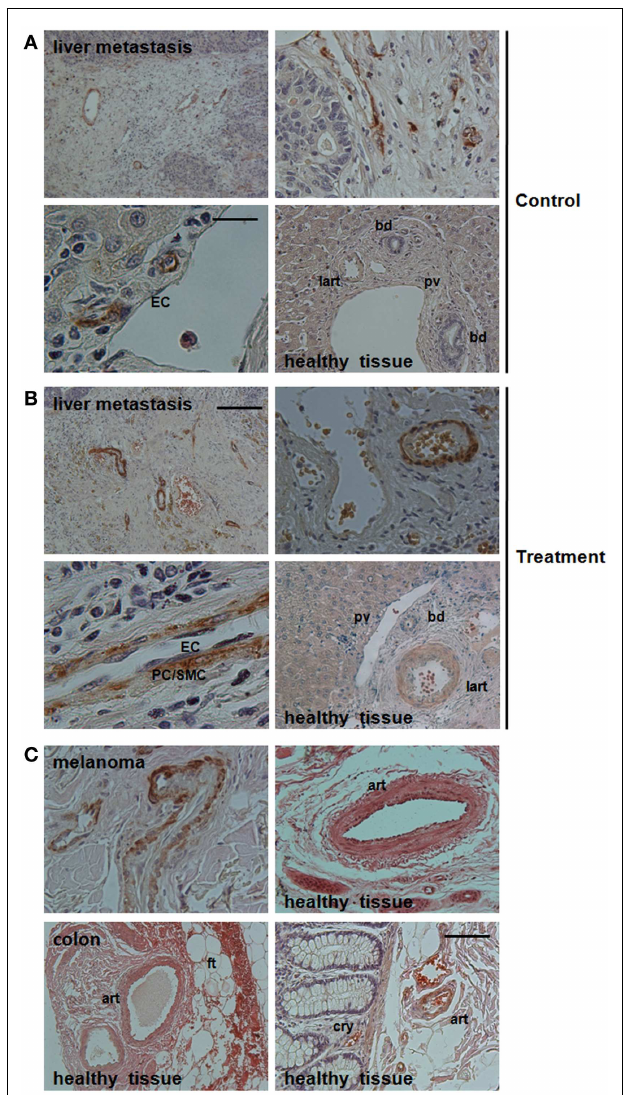
FIGURE 1 | Immunohistological analysis of Nestin-expression in vessel structures in bevacizumab-treated human tumor tissues . (A) Paraffin-sections of liver metastases from colon carcinoma patients without neoadjuvant treatment (Control) were stained for Nestin. Scale bar 50 µ m. (B) Treatment group: sections of liver metastases from colon carcinoma patient having received bevacizumab. Representative images of 19 tissue samples are shown (9 treatment and 10 control samples). Scale bar 20 µ m. (C) Paraffin-sections of human melanoma tissue sections as well as human colon tissue sections were stained for Nestin. Sections were counterstained with hematoxylin. Art, artery; lart, liver artery; pv, portal vein; bd, bile duct; ft, fatty tissue; cry, crypt. Scale bar 10 µ